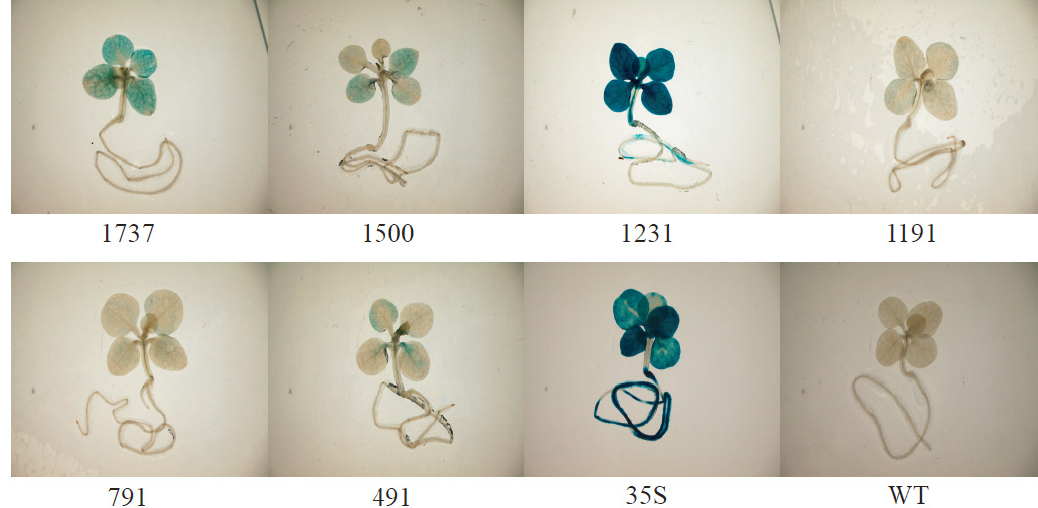
Figure 3. Histochemical GUS staining of 14-day-old transgenic tobacco plants. T transgenic tobacco seeds were germinated on MS medium plates with 30 mg/L 2 Hygromycin B to eliminate the non-transgenic plants. The surviving 14-day-old seedlings were immersed in GUS staining solution and incubated overnight at 37 °C. Then, the samples were de-pigmented with 70% ethanol at 37 °C until the chlorophyll had completely